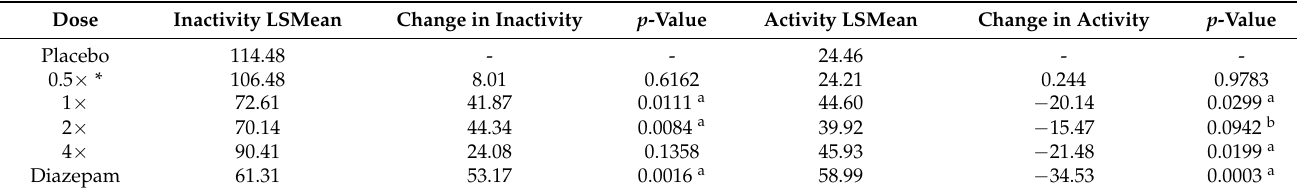
Table 2. Least square means (LSMean) of activity and inactivity time in seconds by dose, and paired difference tests of time for a specific dose versus placebo.